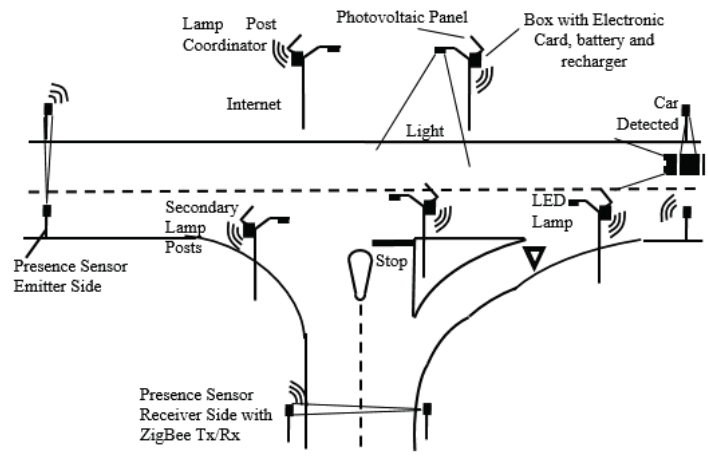
Figure 2. Schematic image of the on street system.